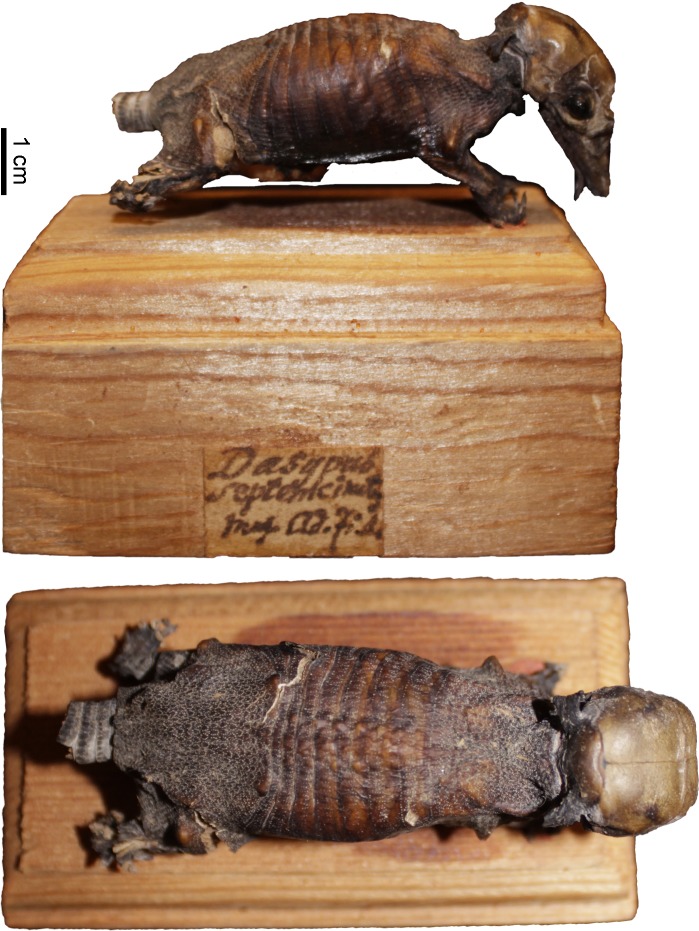
Lateral and dorsal view of the holotype (UPSZTY 24) of Dasypus septemcinctus Linnaeus, 1758, showing the label handwritten by C. P. Thunberg, Linnaeus’ pupil and successor as curator of the Uppsala collection.